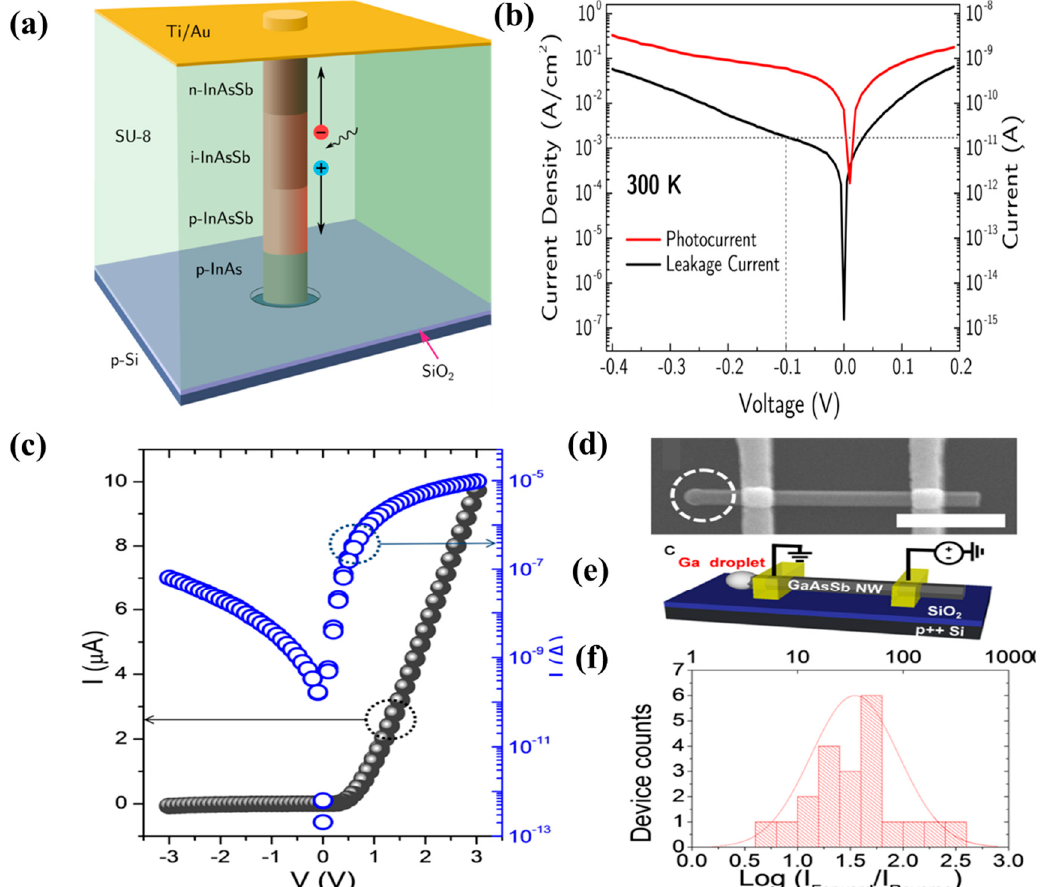
Figure 10. Schematic of p–i–n InAsSb nanowire photodiode. ( a ) The nanowire consists of a 200 nm Be doped InAs stub followed by 500 nm Be doped InAsSb, 500 nm undoped InAsSb, and 500 nm Te doped InAsSb. The nanowire is encapsulated by cross-linked SU-8 with Ti/Au forming the top contact. ( b ) Semilog current − voltage characteristic of InAs 0.93 Sb 0.07 p–i–n photodiode at 300 K with a nanowire diameter of 80 nm and a length of 1.7 µm. The black and red plots show the leakage current and photocurrent density, respectively, for 200 contacted nanowires. At a typical operational bias of − 0.1 V the leakage current is 18 pA, which corresponds to a leakage current density around 2 mA/cm2. For photocurrent measurements, illumination was provided by a 1.55 µm laser to which the substrate is transparent. Reproduced with permission from [44]; Copyright 2016, American Chemical Society. ( c ) Representative current–voltage (I–V) characteristics of a single GaAsSb NW device showing a rectifying behavior. ( d ) SEM image of the GaAsSb NW device with the Ga droplet marked by a dashed circle. The scale bar is 1 µm. ( e ) Schematic of the single GaAsSb NW device. The GaAsSb NW is placed on a SiO 2 /p+2-Si substrate and contacted with two identical metal electrodes. ( f ) A histogram of the current rectification ratio (IForward/Ireverse) at ±3 V for 21 different NW devices. The distribution is fitted with a Gaussian curve. Reproduced with permission from [90]; Copyright 2015, American Chemical Society.